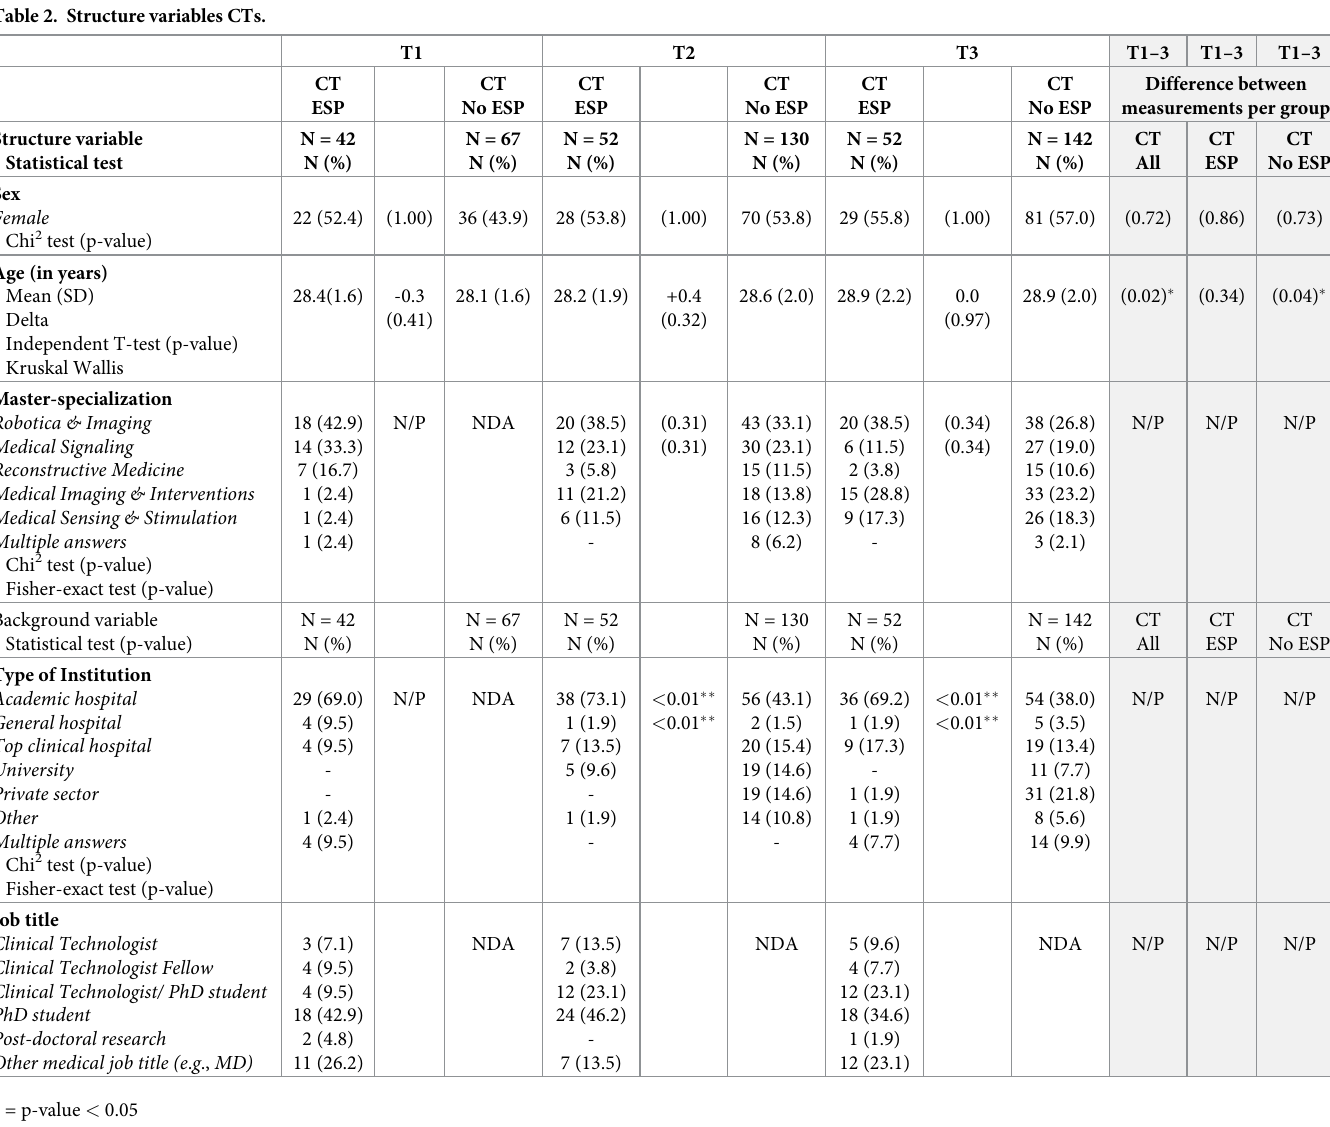
Table 2. Structure variables